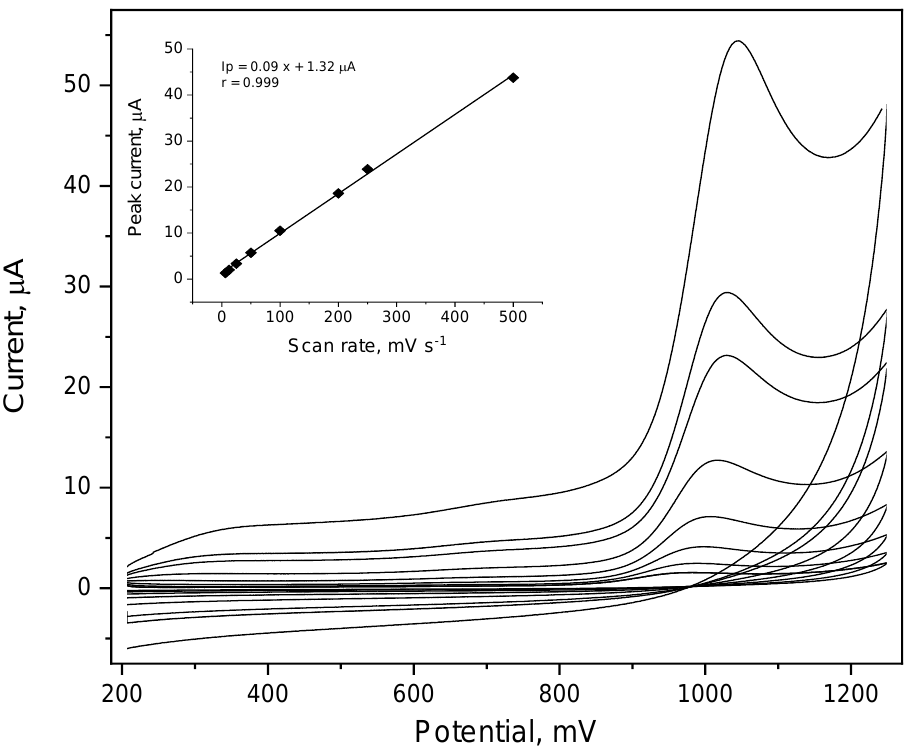
Figure 3. Cyclic voltammograms of the 5 µ mol L − 1 of vortioxetine registered in the 0.1 mol L − 1 phosphate buffer (pH 6.0) for the scan rate values of: 6.3; 12.6; 25; 50; 100; 250, and 500 mV s − 1 , and the linear dependence of the VOR peak on the scan rate value.